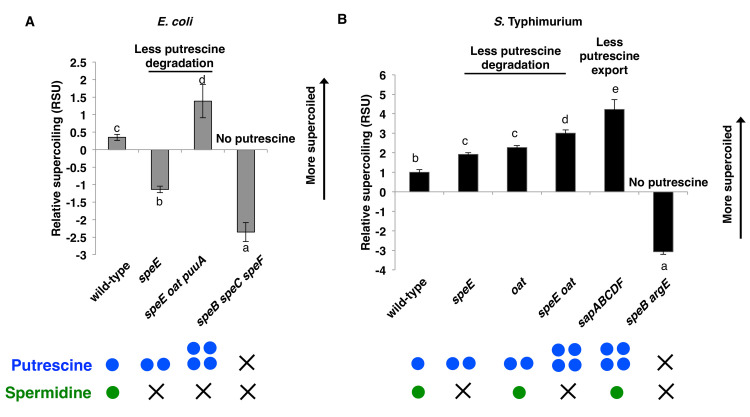
Putrescine increases negative DNA supercoiling in vivo.DNA supercoiling in the indicated E. coli (A) and S. Typhimurium (B) strains, which differ in putrescine abundance. E. coli strains used were: MG1655 (wild-type), AAD85 (speE), AAD96 (speE oat puuA), AAD95 (speB speC speF). S. Typhimurium strains used were: 14028s (wild-type), AAD46 (speE), JY979 (oat), AAD58 (speE oat), EG6501 (sapABCDF), AAD212 (speB argE). Coloured circles qualitatively represent expected concentrations of putrescine (blue) or spermidine (green). Different lowercase letters indicate pairwise statistical significance (Tukey’s HSD, p<0.05, n = 7 for S. Typhimurium wild type, n = 4 for S. Typhimurium speE, n = 2 otherwise). The growth curves corresponding to the cultures used in these experiments are presented in S1 Fig.